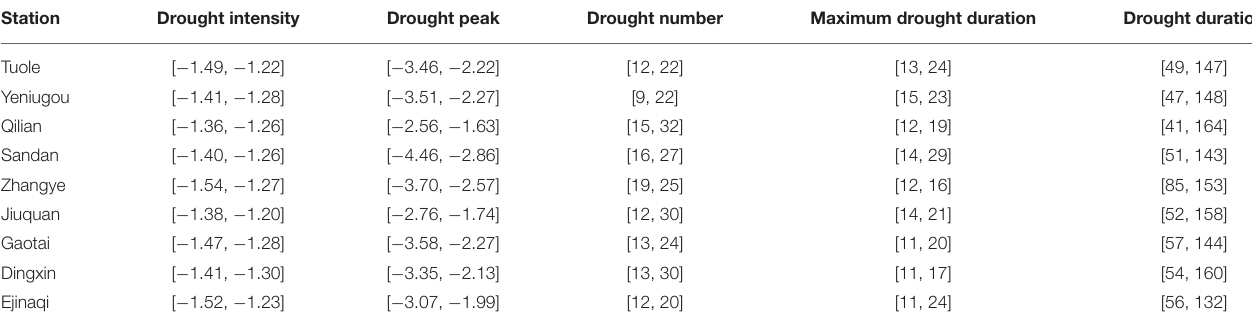
TABLE 4 | The intervals of drought characteristics considering parameter estimation